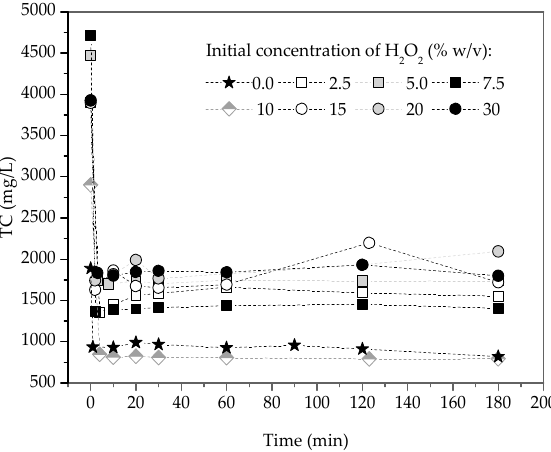
Figure 1. Effect of artificial ultraviolet light on the photodegradation of OMW (photolysis). A ) Variation of TOC value of two different OMW with high (Initial TOC = 3929 mg/L) and low (Initial TOC = 1086 mg/L) organic loads throughout the photodegradation. B ) Variation of the global removal percentages of TOC, TC, IC and TN parameters for OMW with different organic loads. Common operating conditions: pH = 3, T = 20 °C and stirring speed = 150 rpm.